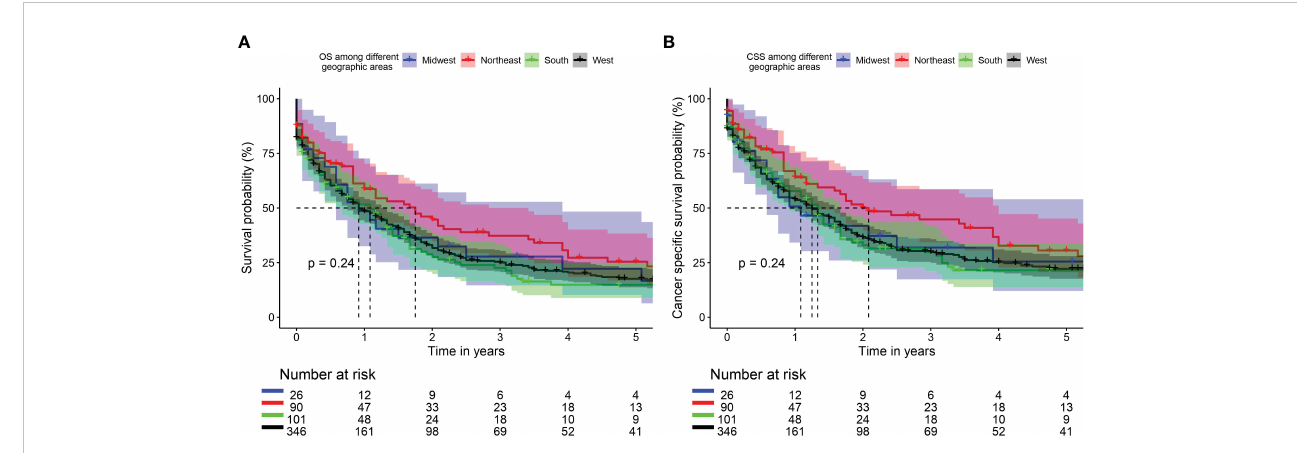
FIGURE 1 Kaplan Meier curve of overall survival (OS) (A) and cancer speci fi c survival (CSS) (B) among different geographic